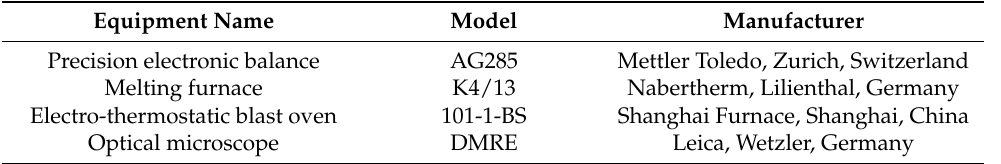
Table 3. The list of apparatus and